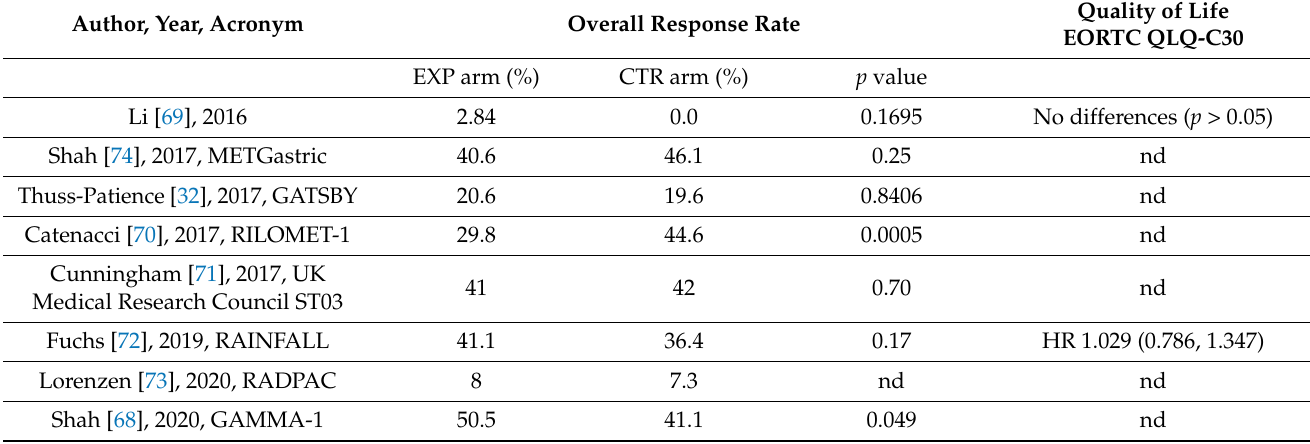
Table 4. Overall response rate and quality of life. This table summarizes the overall response rate based on RECIST criteria reported in the experimental and in the control arm for each study. The quality of life was reported according to EORTC QLQ-C30 questionnaire, which measure cancer patients’ physical, psychological, and social functions. This questionnaire is composed of multi-item scales and single items.